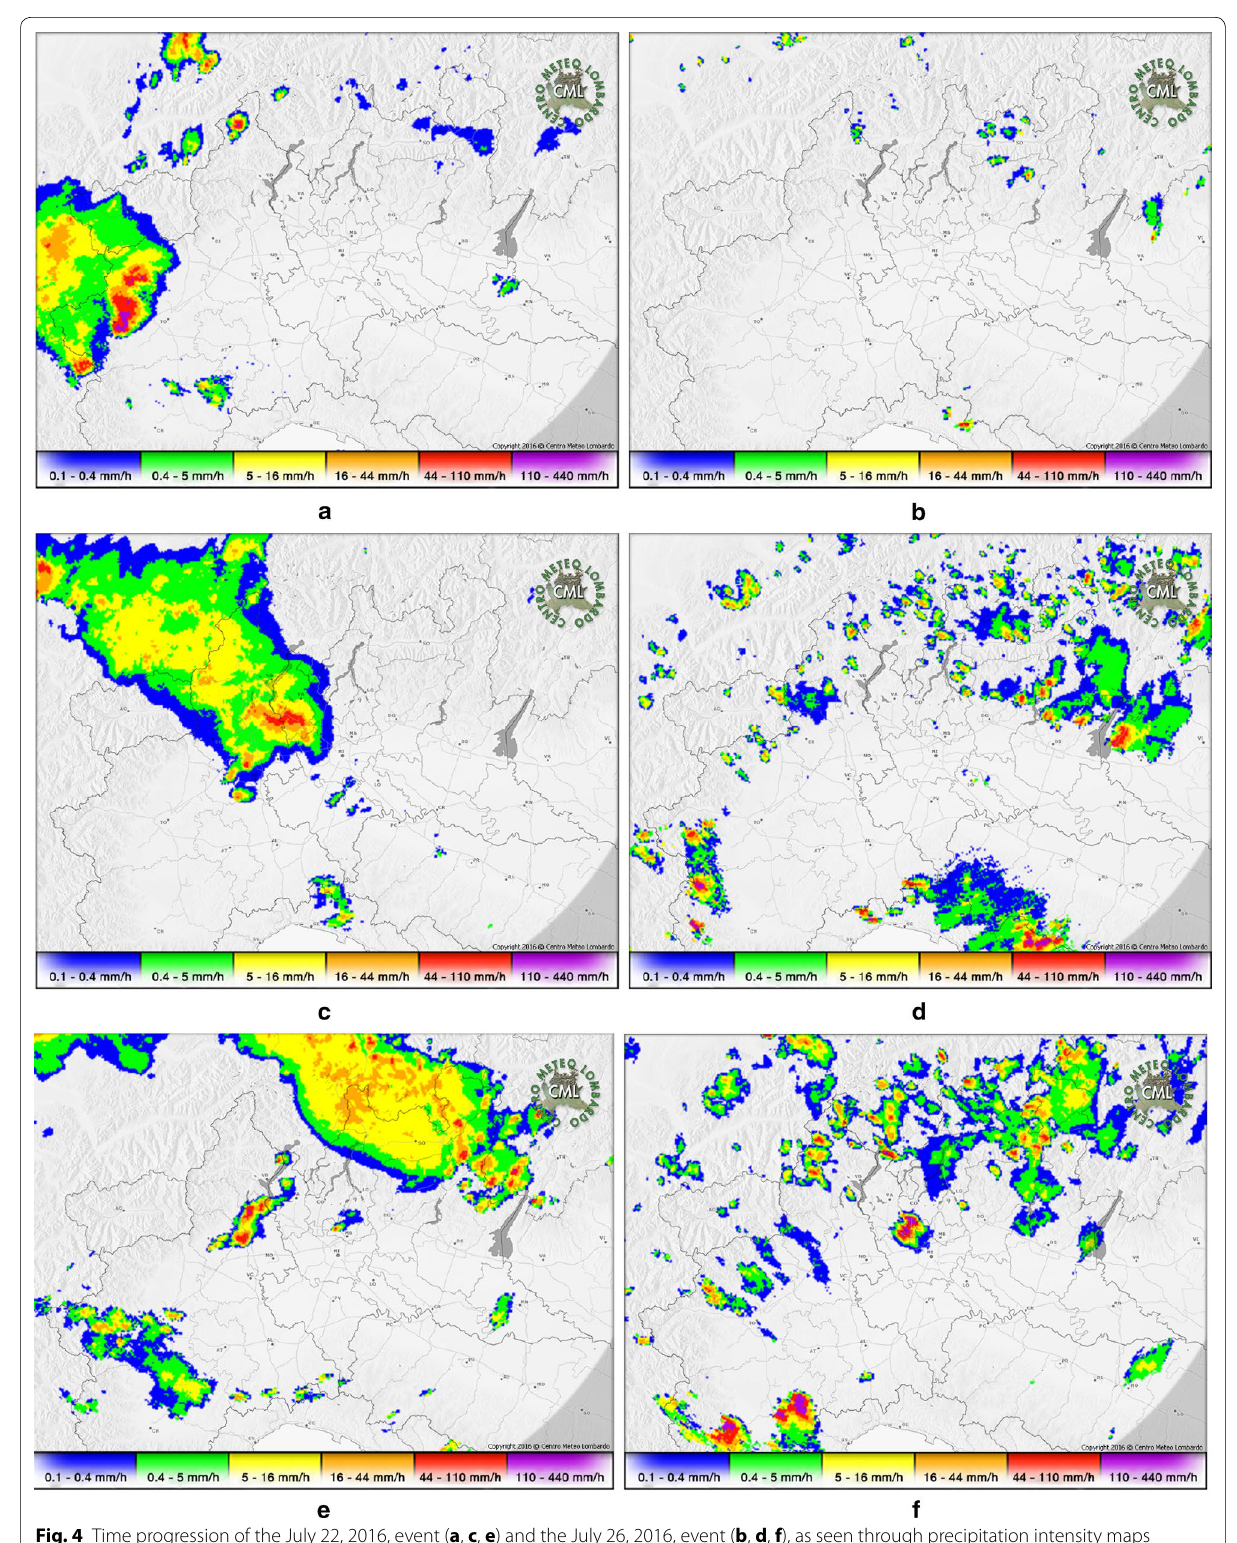
Fig. 4 Time progression of the July 22, 2016, event ( a , c , e ) and the July 26, 2016, event ( b , d , f ), as seen through precipitation intensity maps derived from radar reflectivity observations. Such maps are published by the Centro Meteo Lombardo-CML, based on MeteoSwiss radar data. LT local time. a July 22—07:00 LT. b July 26—12:00 LT. c July 22—10:00 LT. d July 26—15:00 LT. e July 22—13:00 LT. f July 26—18:00